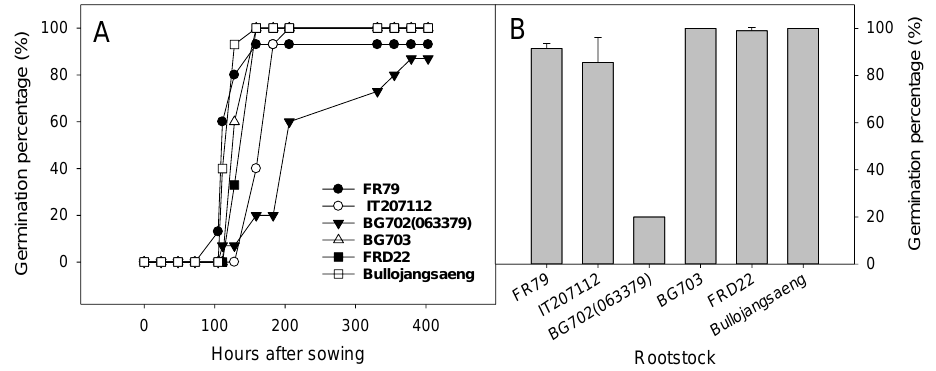
Figure 3. Germination percentage of Lagenaria rootstock accessions after sowing ( A ) and at seven days after sowing ( B ).